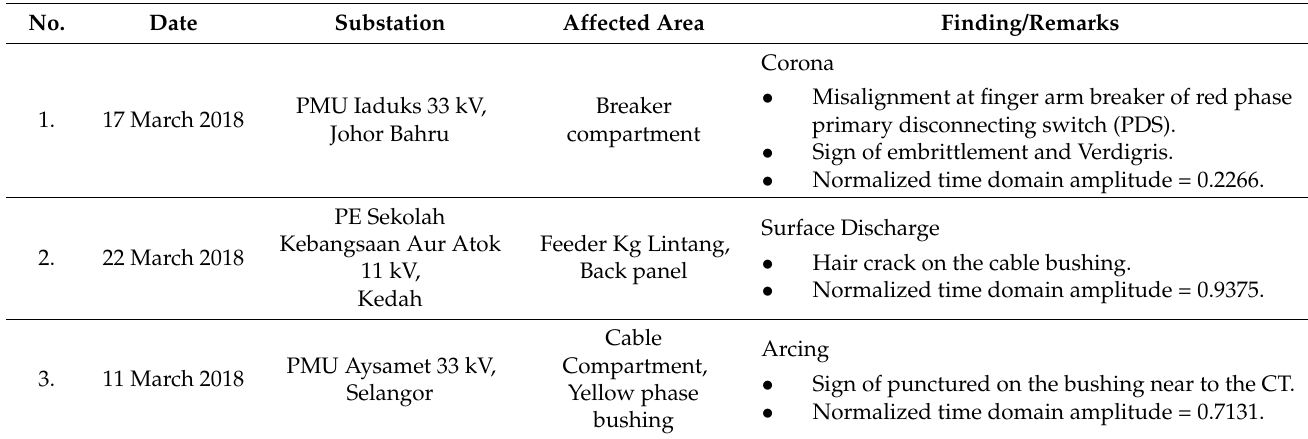
Table 5. Case studies in PUC